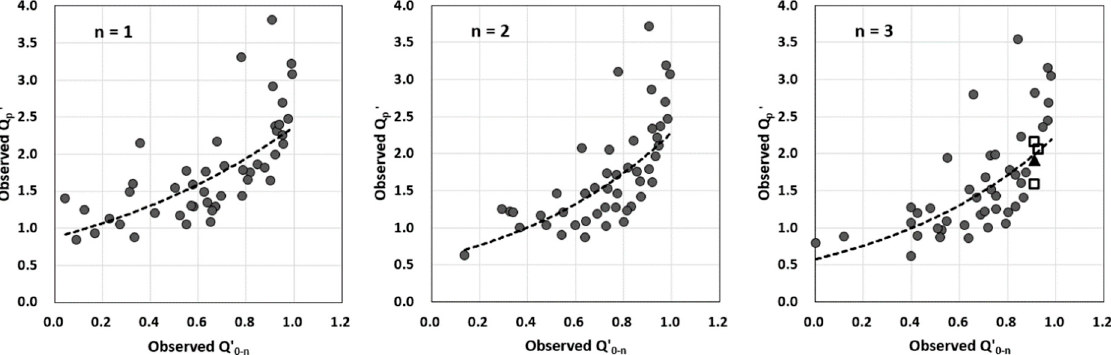
Figure 5. Relationship between the standardized instantaneous flood peak and the standardized daily flood hydrograph rising-limb steepness index (unit: m 3 /s/ ( 86,400 m 3 )).